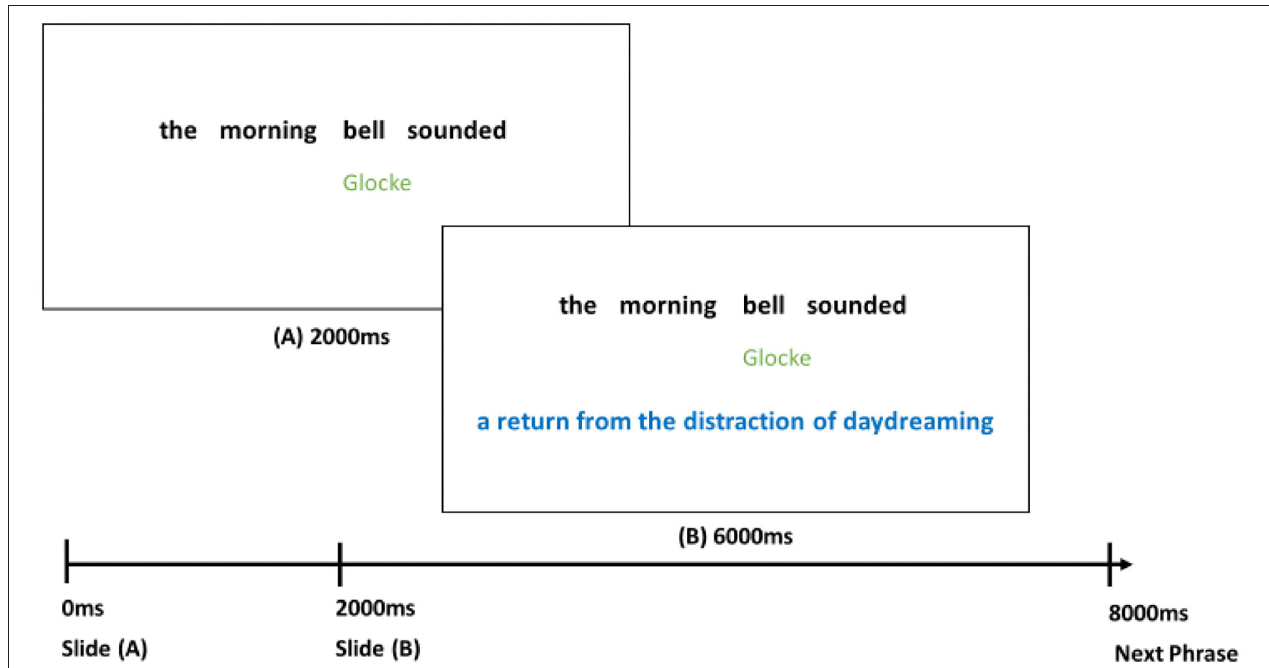
FIGURE 1 | Slide Presentation Timing and Display with Example. The timing of slide presentation displayed from left to right include the phrase in black, German glosses in green, and after 2,000ms, the meaning of the phrase in blue. In total, the phrase is displayed for the full 8,000ms before the next phrase appears.